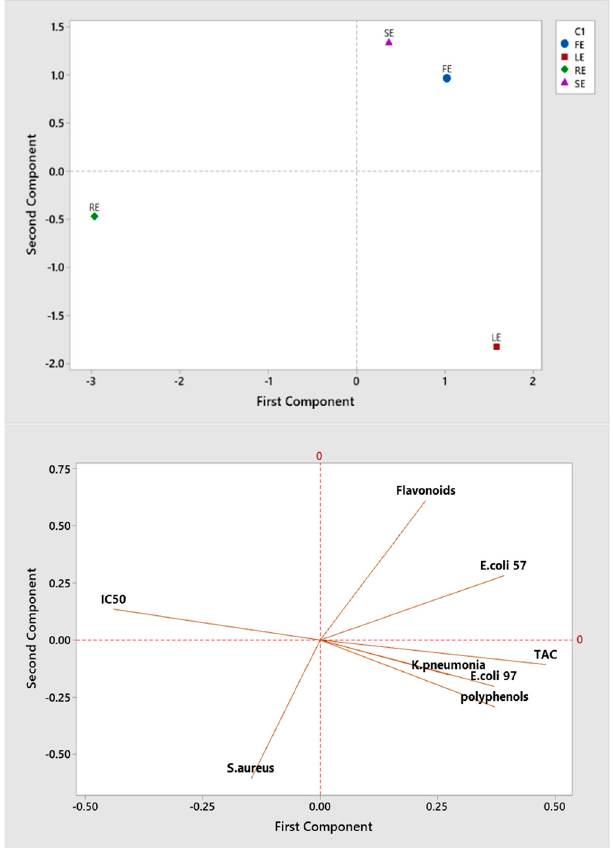
Figure 3. Principal component analysis of different studied parameters.